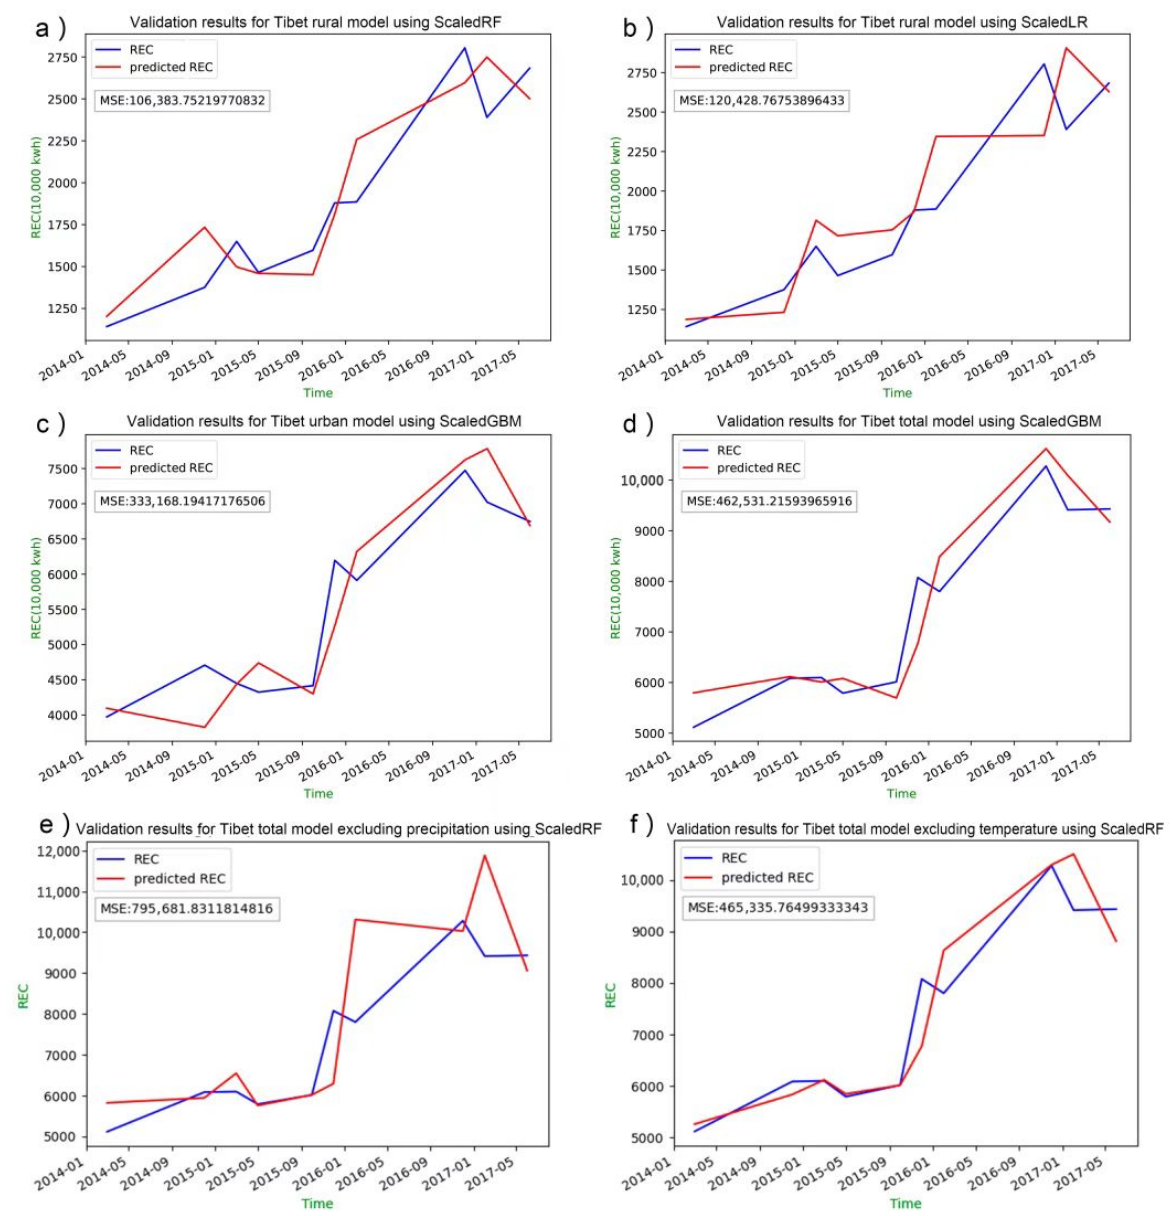
Figure 3. Model validation results. Plots ( a – d ) show the model validation results of the tree-based rural model, linear rural model, urban model, and total model for Tibet. Plots ( e , f ) show the results of the model trained without precipitation and without temperature, respectively. The red curves represent the REC estimates made based on the model and the blue curves show the validation REC data. MSE, mean squared error.